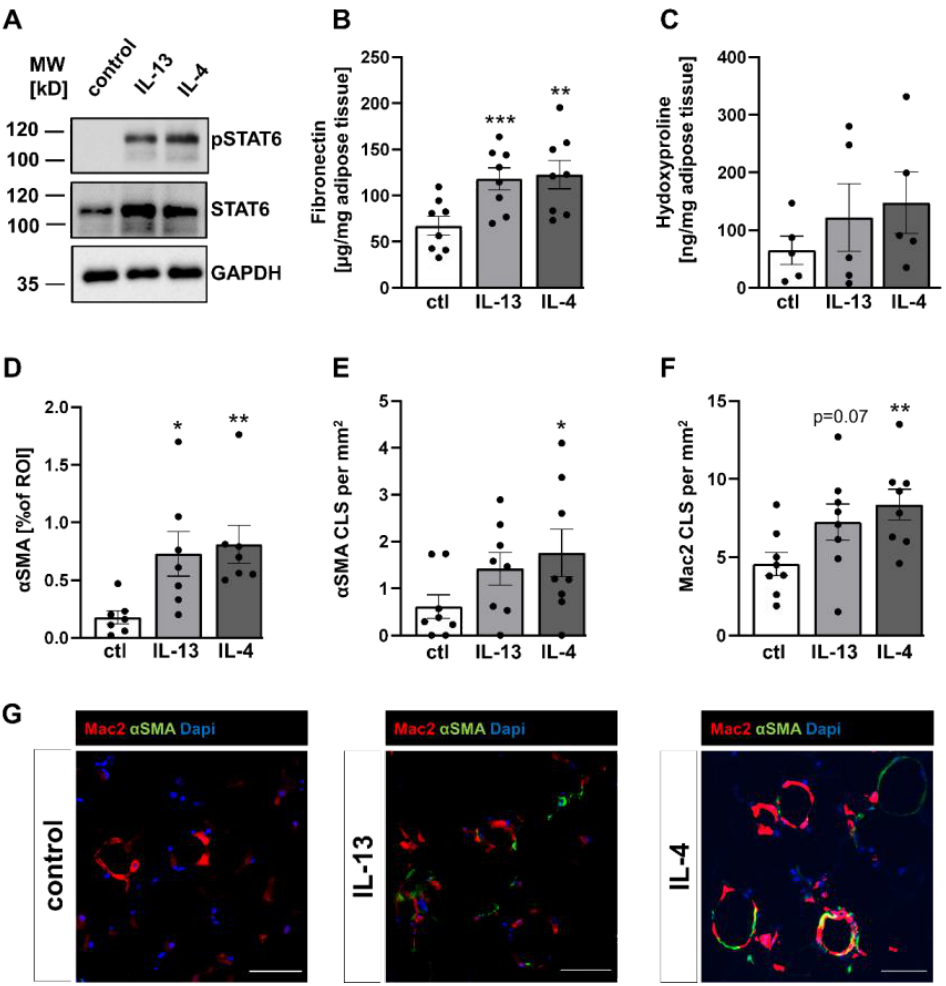
Figure 2. Increased STAT6 phosphorylation and fibrosis-associated proteins were induced by IL-13 and IL-4. WAT explants from C3H mice were stimulated with either IL-13 (50 ng/mL) or IL-4 (50 ng/mL) or non-stimulated (control) for four days. ( A ) A representative immunoblot from WAT explant lysates using antibodies against phosphorylated STAT6, total STAT6 and GAPDH to assess equal protein loading, from four independent experiments. ( B ) Levels of fibronectin were determined in supernatants of the explants (n = 8) by ELISA. ( C ) Collagen content in WAT explants was measured by hydroxyproline colorimetric assay (n = 5). ( D ) The area of α -SMA positive cells (n = 7), ( E ) the number of α -SMA positive crown-like structures (CLS, n = 8) and ( F ) the number of Mac-2 positive CLS (n = 8) in WAT explants were assessed by α -SMA (green) and Mac-2 (red) immunofluorescence staining. ( G ) Representative images of α -SMA and Mac-2 immunofluorescence staining. DAPI was used for nuclei counterstaining (blue). Data represented as mean ± SEM. * p -value < 0.05; ** p -value < 0.01; *** p -value < 0.001; scale bars = 50 µm. In many tissues affected by fibrotic diseases, αSMA expression levels were used to identify myofibroblasts, the major collagen-producing cell type in fibrotic tissues [22,23]. Immunofluorescence analysis revealed that αSMA -positive cells were increased 3 to 4- fold after IL-13 or IL- 4 stimulation in C3H mice (Figure 2D). In addition to single αSMA - positive cells, presumably myofibroblasts, we also observed an αSMA -positive circular staining pattern, resembling crown-like structures (CLS; an accumulation of ATMs sur- rounding dying adipocytes). The presence of ATMs within these circular structures was confirmed by the macrophage marker Mac-2. Hence, we defined these structures as αSMA - positive CLS (αSMA -CLS). W e found significantly higher numbers of αSMA -CLS in AT explants stimulated with IL- 4, whereas the increase of αSMA -CLS after IL-13 treat- ment did not reach significance (Figure 2E). Most interestingly, a few CLS-associated ATMs showed co- expression of αSMA (Figure 2G), while interstitial ATMs (outside of CLS) revealed no obvious αSMA expression, suggesting a correlation between ATMs in CLS and αSMA expression. In addition, the numbers of Mac -2 positive CLS were also elevated after IL-13 and IL-4 stimulation, raising the question of a positive correlation be- tween number of CLS, as marker for inflammation, and αSMA -positive areas (Figures 2F